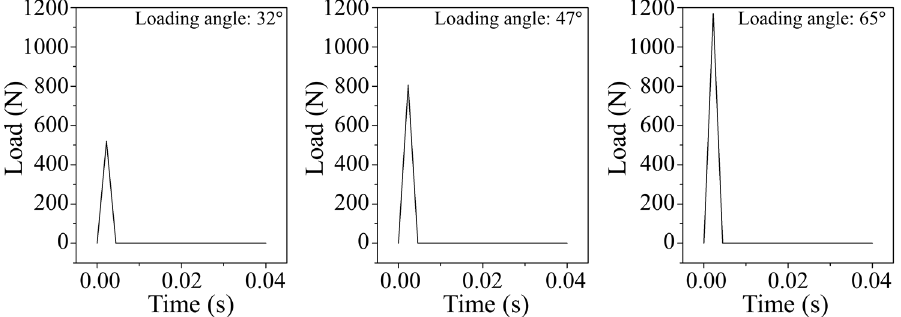
Figure 4. Reconstructed impact